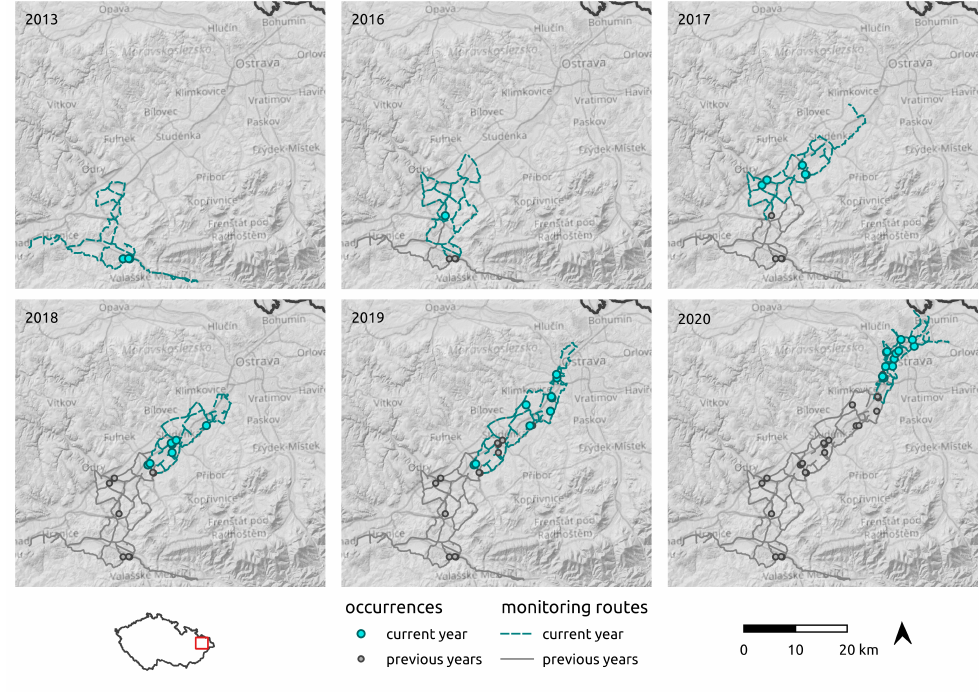
Figure 2. Driving routes used to monitor the spread of R. nitidula in the Odra River basin and R. nitidula detections in a 5-year